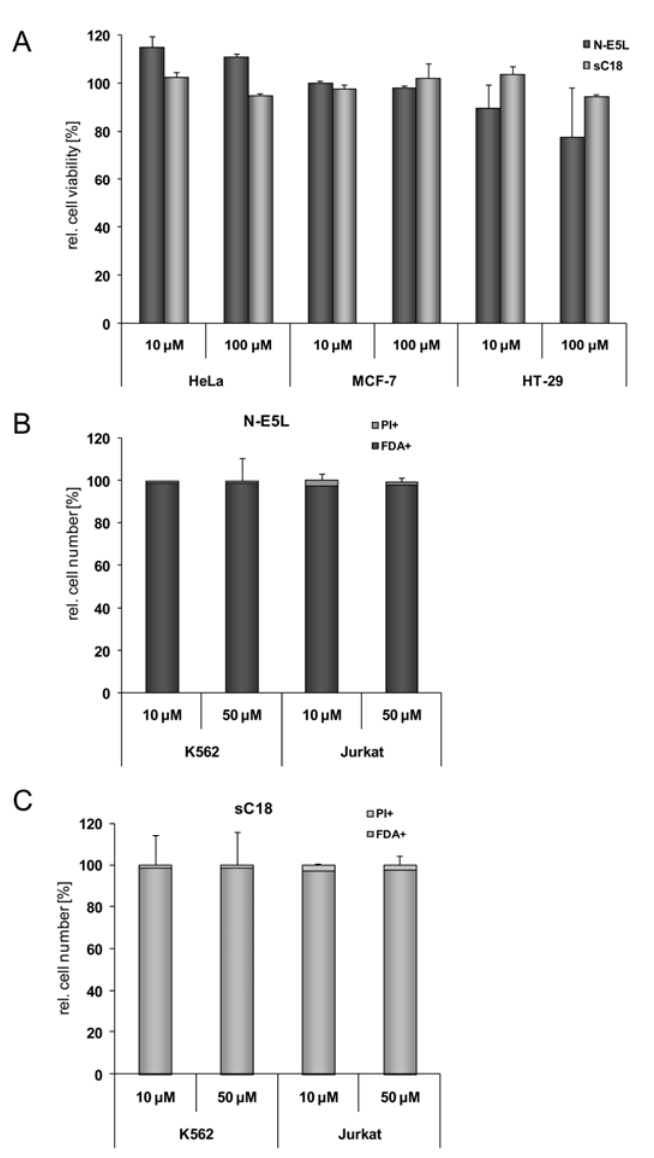
Figure 3. Cytotoxicity profile of sC18 and the N-E5L sequence in MCF-7, HT-29 and HEK293 cells after incubation with 10 µM and 100 µM peptide solutions (a). (b) N-E5L and sC18 (c) in K562 and Jurkat cells after incubation with 10 and 50 µM peptide